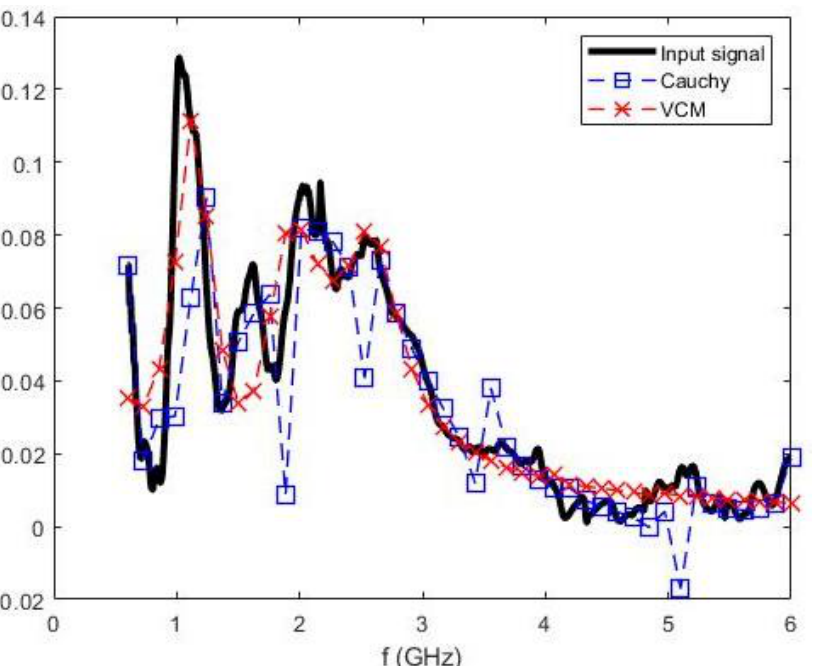
Figure 11. Backscattering signal reconstruction with the Cauchy and VCM methods corresponding to an electric metal detonator for IEDs in Colombia.